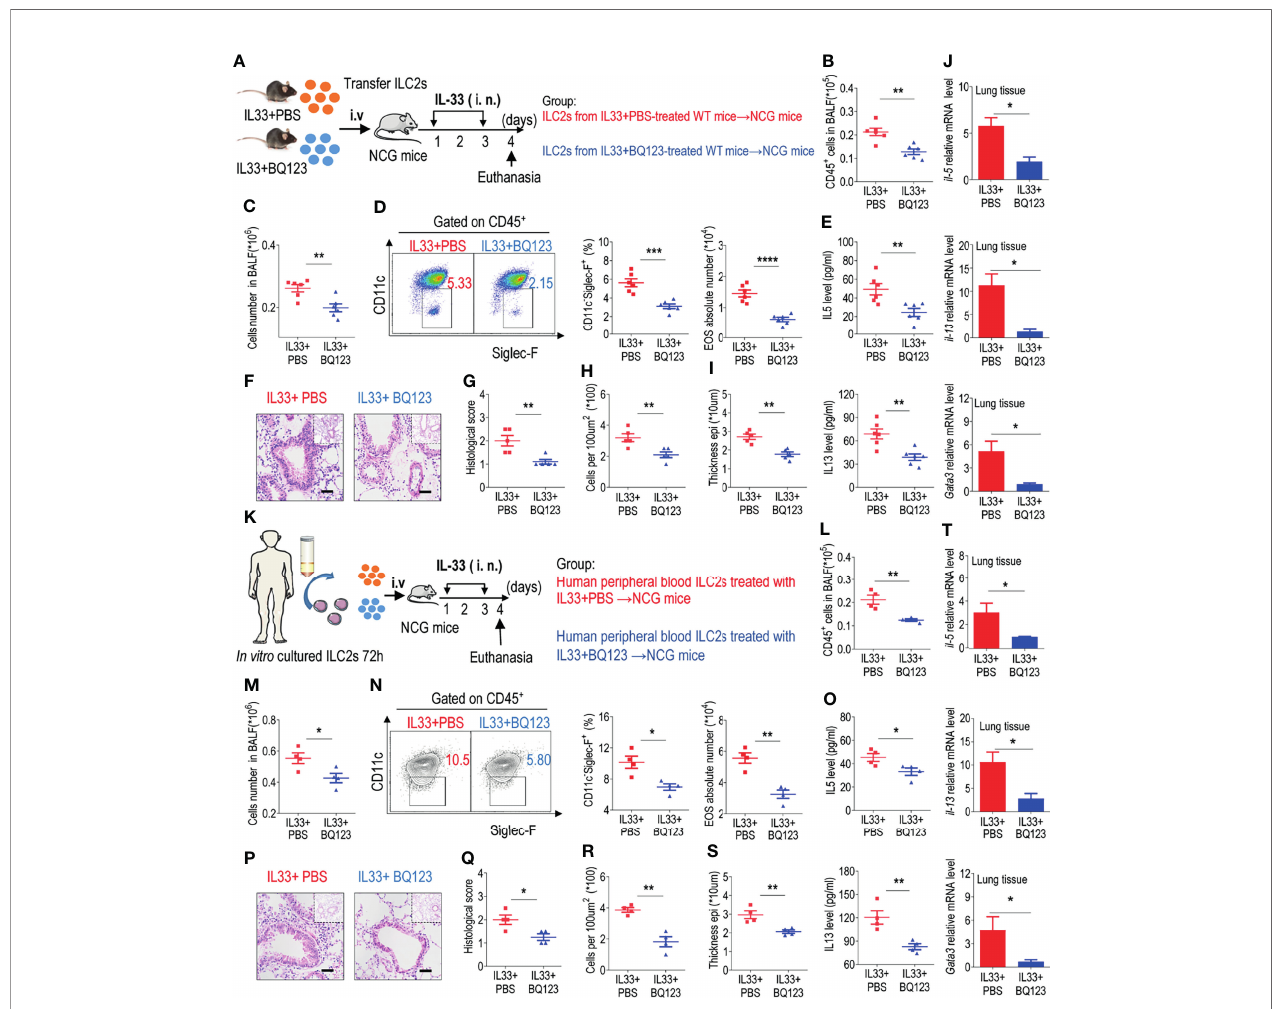
FIGURE 5 | BQ123 alleviated airway in fl ammation by impairing ILC2 function. (A, K) Experimental scheme. ILC2s (approximately 5 × 10 4 in 200 µL) were adoptively transferred intravenously into recipient NCG mice. Mice were intranasally challenged with IL-33 for three consecutive days, and the bronchoalveolar lavage fl uid (BALF) and lung tissues were analyzed on day 4. (B, L) The number of total CD45 + cells in BALF. (C, M) Absolute number of BALF. (D, N) Typical example of fl ow cytometry (left) and statistical results (right) of population and the absolute number of EOS in the BALF. (E, O) IL-5 and IL-13 levels in the BALF. (F – I, P – S) Representative hematoxylin and eosin (H&E) staining of lung sections and in fl ammation scores, as well as the in fi ltrating cells and airway epithelium thickness were shown. Bars, 100 m m. (J, T) mRNA expression levels of Il5 , Il13 , and Gata3 were evaluated; b -actin level was used for normalization, and the lowest expression level in the IL33 + BQ123 group was arti fi cially set to 1. Data are representative of two independent experiments (n = 6 for the IL-33 mouse model; n = 4 for the humanized IL-33 mouse model). Note: *P < 0.05; **P < 0.01; ***P < 0.001; ****P < 0.0001. In all panels, individual results and mean ± standard error of the mean (SEM) are shown; statistical signi fi cance was determined using a two-tailed unpaired Student ’ s t-test (B – E, G – J, L – O, Q – T)